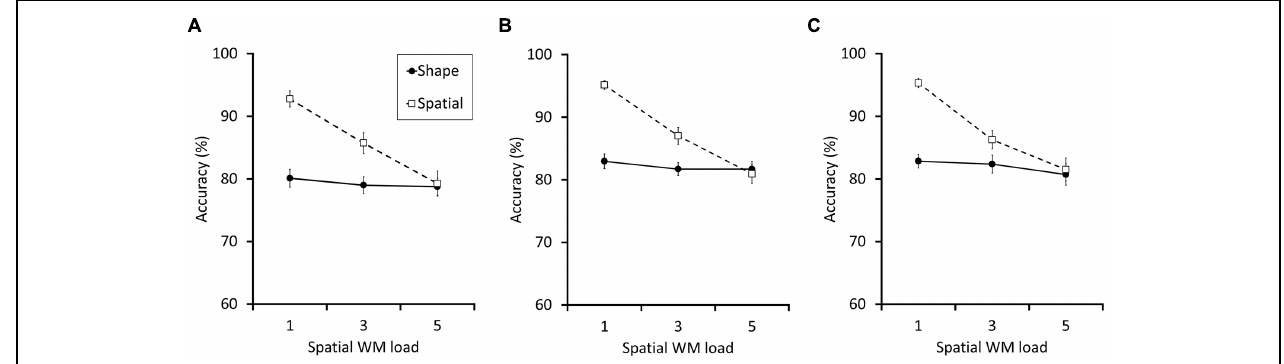
FIGURE 2 | The results for Experiments 1a (A), 1b (B), and 1c (C). The broken lines with empty squares and the solid lines with filled circles indicate the accuracy (% correct) of the spatial and the shape WM test trials, respectively. In